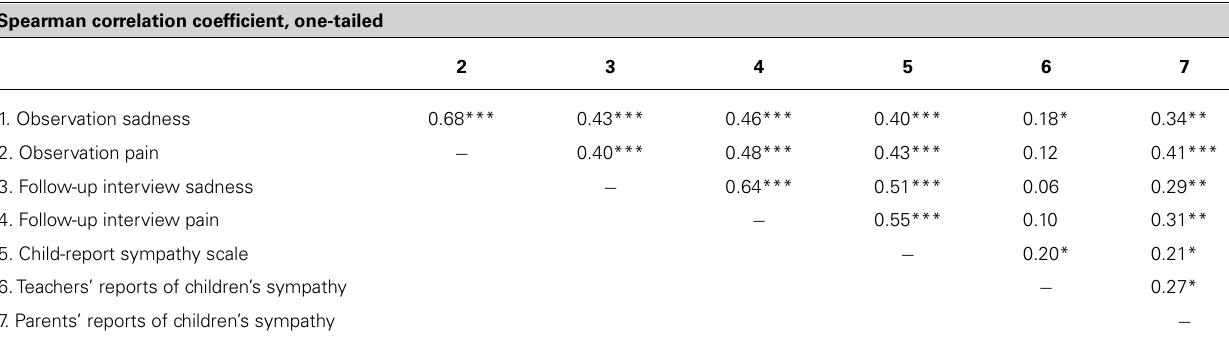
Table 4 | Intercorrelations of the methods measuring sympathyT3. Spearman correlation coefficient,